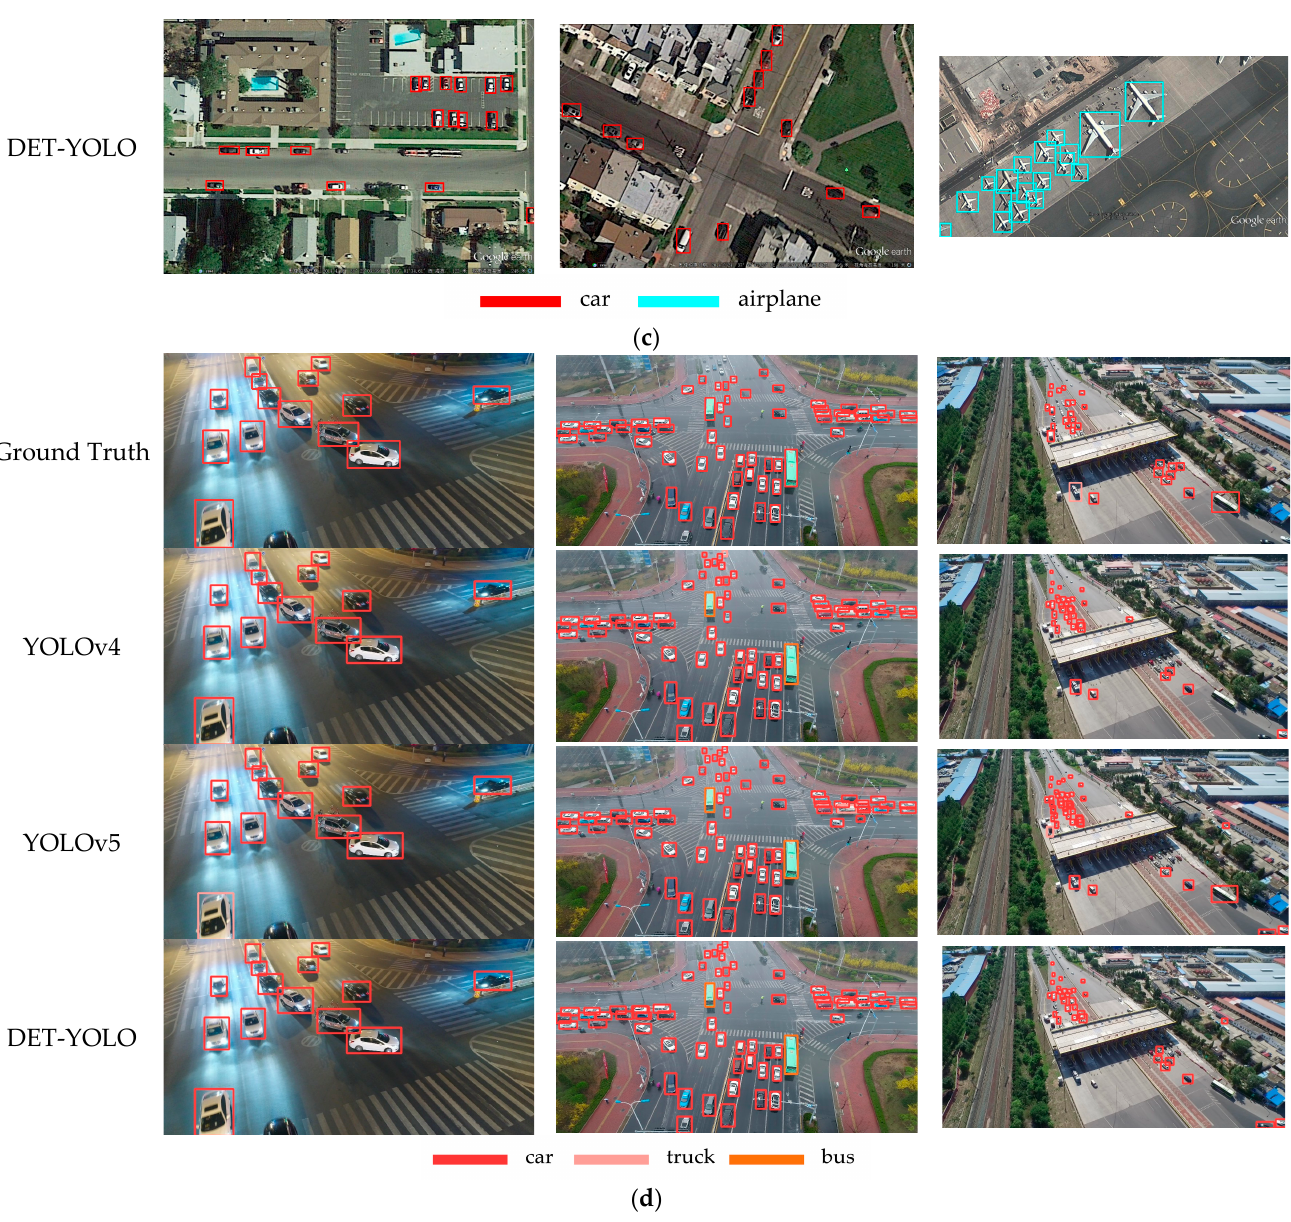
Figure 10. Experimental results for ( a ) DOTA dataset; ( b ) RSOD dataset; ( c ) UCAS-AOD dataset; and ( d ) UAVDT dataset.